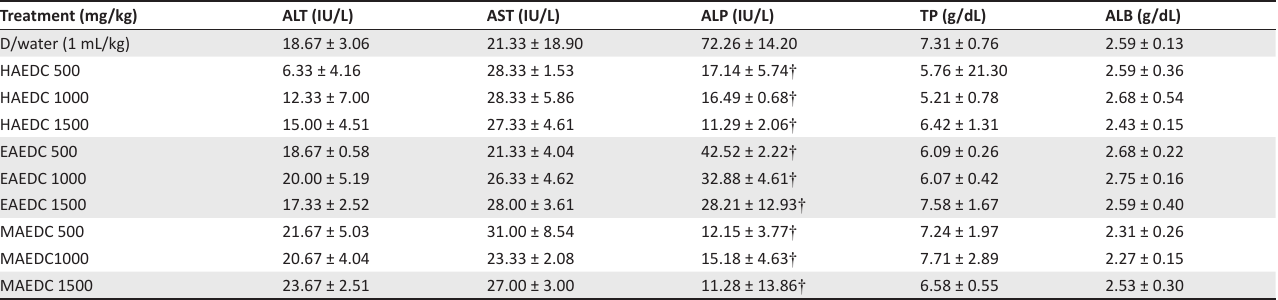
TABLE 3: Effect of n -hexane, ethyl acetate and methanol extracts of Daucus carota aerial part on hepatic indices of Wistar rats after oral administration for 28 days. Treatment